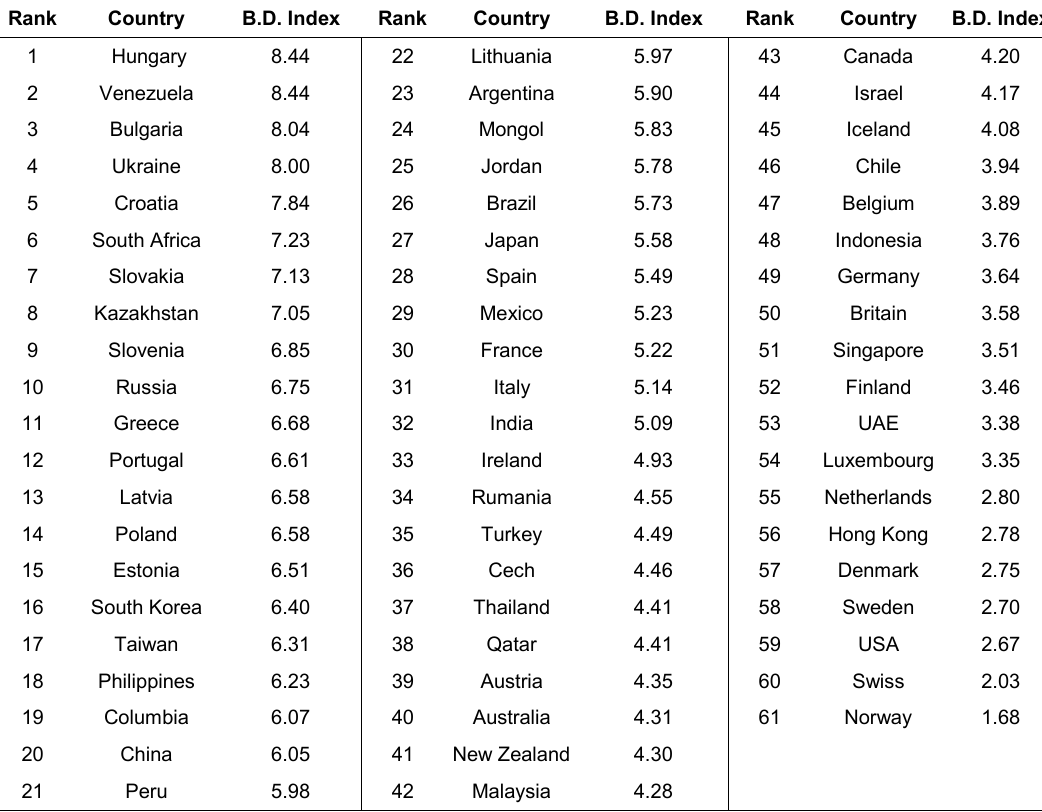
Table 2. Rankings of IMD Brain Drain Index by Country in 2016 4